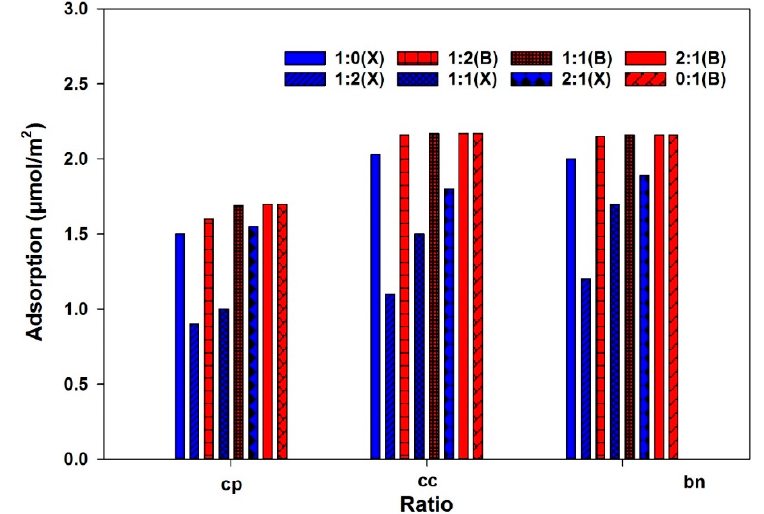
Figure 9. Adsorption of collectors from the mixtures of SIBX(X) and BBT(B) at pH 8.2 and total concentration 3 × 10 − 5 M (BBT was added first); cp-chalcopyrite, cc-chalcocite, bn-bornite.